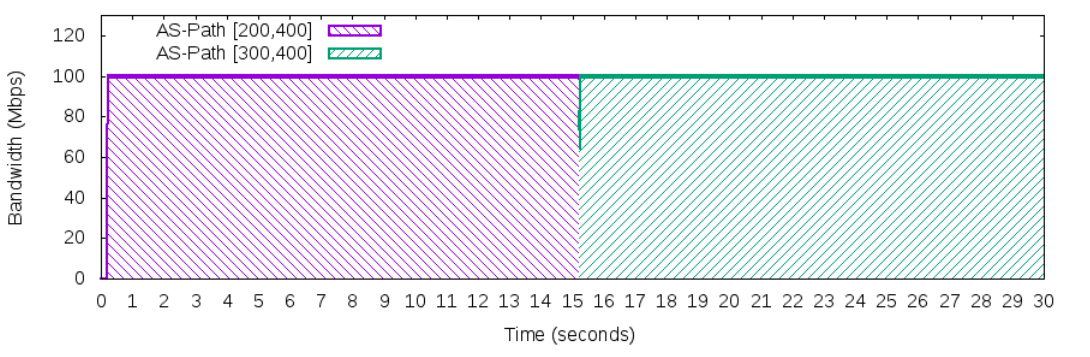
Figure 11. An execution of link failure in the 15th second.